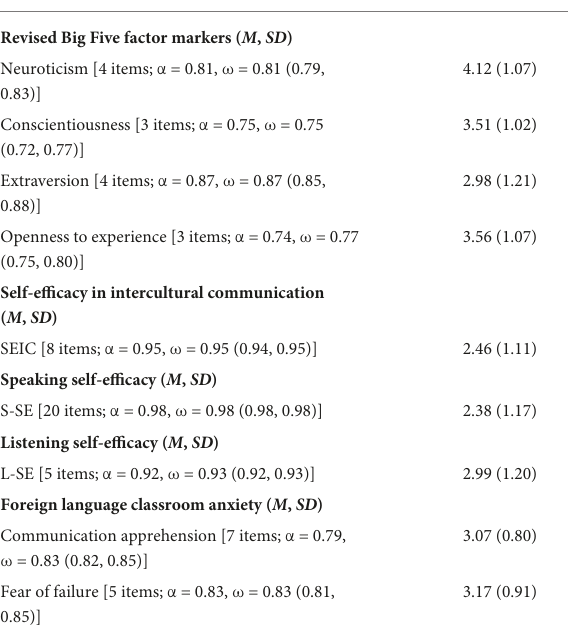
TABLE 1 Descriptive statistics and reliability for the study variables with emerging adults ( n = 1,326) in